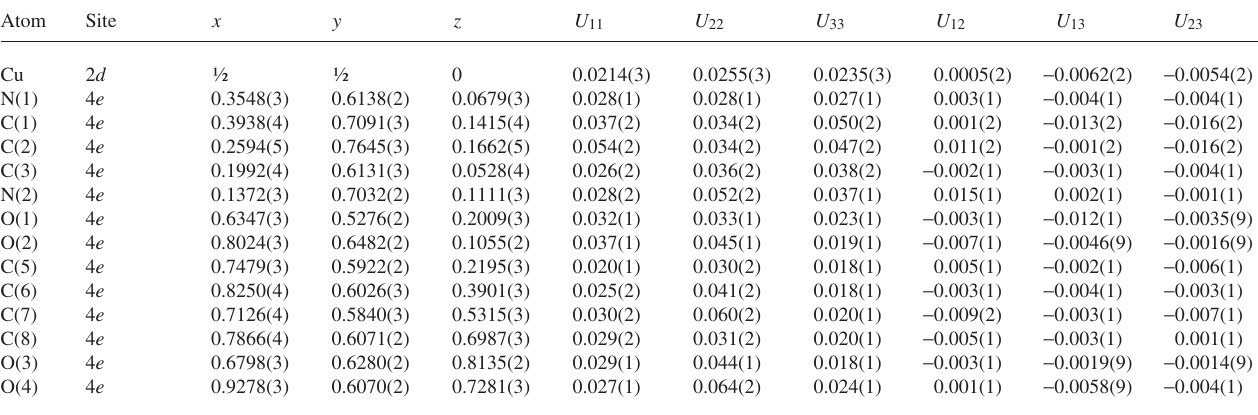
Table 3. Atomic coordinates and displacement parameters (in Å 2 )